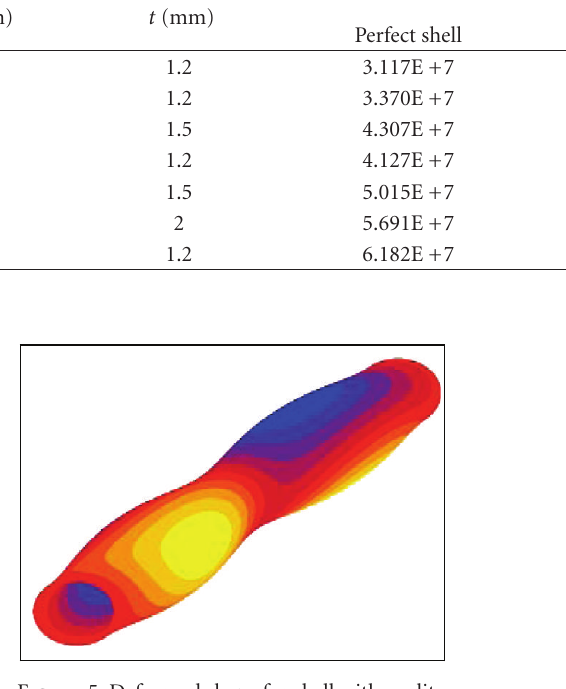
Figure 5: Deformed shape for shell with ovality. Figure 6: Deformed shape for shell with